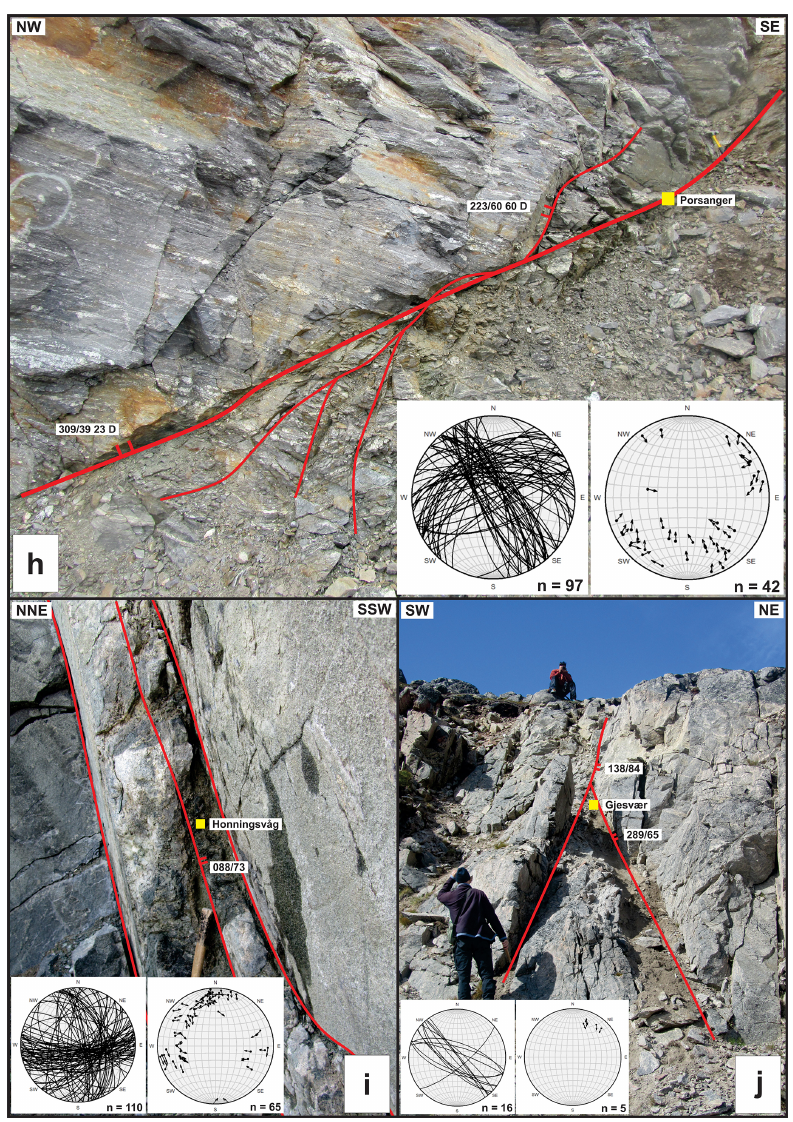
Figure 2. Outcrop photographs of the dated faults. Each photograph is accompanied by the location of the dated samples (yellow squares; see Fig. 1 for sample location), structural measurements presented in white boxes and in Schmidt stereonets (left-hand-side stereonets show fracture surfaces as great circles and right-hand-side stereonets display slickenside lineations as pole-to-fault surfaces indicating the movement of the hanging wall), and potential kinematic indicators where available. (a) NNW-dipping Altafjorden fault 1 (sample 3) cross- cutting Precambrian rocks of the Alta–Kvænangen tectonic window along the western shore of Altafjorden. A potentially drag-folded mafic bed is shown in blue. Modified after Koehl et al. (2018b); (b) NNW-dipping Altafjorden fault 2 (sample 4) within the Alta–Kvænangen tectonic window. The country rock displays preserved bedding surfaces (in dotted yellow); (c) NNW-dipping fault in the footwall of the Sørkjosen fault (Sørkjosen 1; sample 1). A potentially offset mafic bed is shown in green and the bedrock fabric in dotted orange. The lower left frame is a zoomed-in image of the fault core displaying the location of the dated sample; (d) NNW-dipping fault in the footwall of the Sørkjosen fault (Sørkjosen 2; sample 2). Dotted yellow lines show normal offsets of mafic beds across brittle faults; (e) north-dipping Talvik fault (sample 5) cross-cutting rocks of the Kalak Nappe Complex along the western shore of Altafjorden. Kinematic indicators include ductile fabrics made of microshears (lower left frame), sigma clasts (middle left frame) and slickenside lineations (upper right frame). The bedrock fabric is shown in green. Modified after Koehl et al. (2018b); (f) NNE–SSW-striking brittle faults cross-cutting rocks of the Kalak Nappe Complex along the eastern shore of Altafjorden (sample 6); see normal offsets of geological markers (in green and blue). Modified after Koehl et al. (2018b); (g) SE-dipping fault segment of the Snøfjorden–Slatten fault (sample 7) in Snøfjorden, on the Porsanger Peninsula. Modified after Koehl et al. (2018b); (h) low-angle NNE-dipping fault (sample 8) cross-cutting rocks of the Kalak Nappe Complex on the Porsanger Peninsula; (i) steep, E–W- to WNW–ESE-striking faults (sample 9) within the gabbroic rocks of the Honningsvåg Igneous Complex; (j) steep, WNW–ESE-striking brittle faults near Gjesvær (sample 10), in the western part of Magerøya. The faults cross-cut rocks of the Kalak Nappe